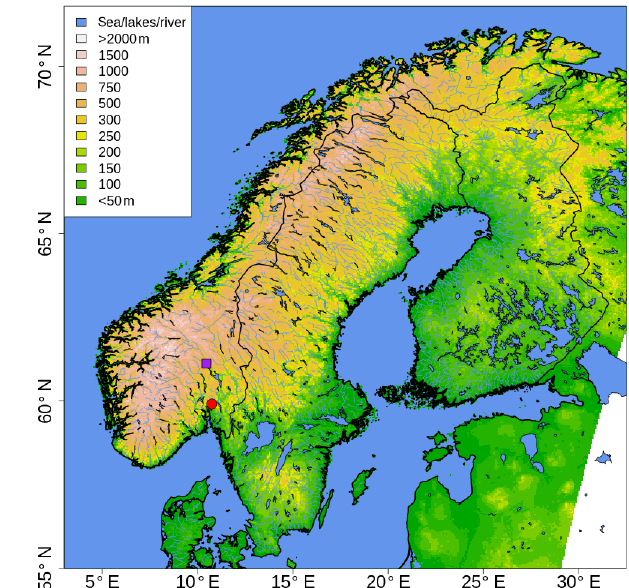
Figure 1. Spatial domain, in the geographical coordinate system, used for the example application. The sea, large bodies of water and rivers are shown in blue. The altitude above the mean sea level (in m) is shown through shaded colors. The red circle marks Oslo. The purple square marks